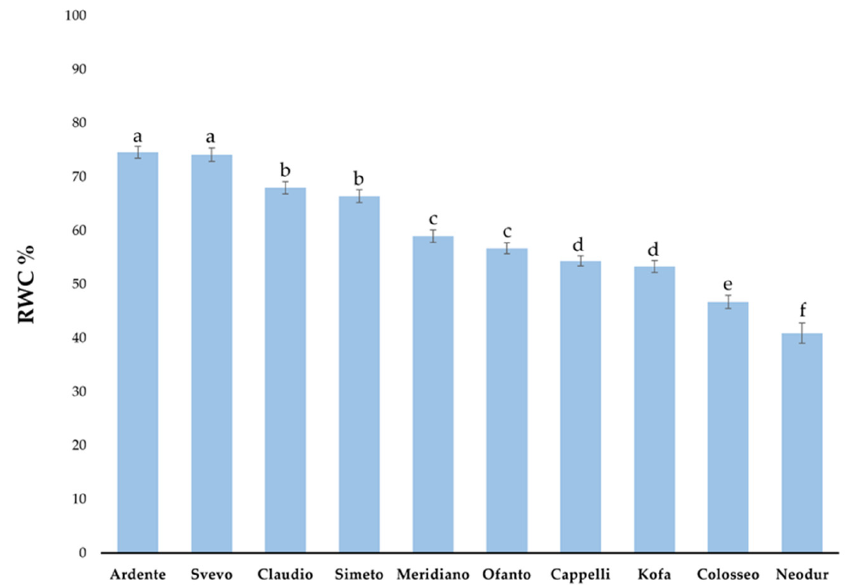
Figure 3. Relative water content (RWC) measured in seedlings of ten T. durum cvs in response to dehydration for 2 h. Different letters indicate a significant difference at p < 0.05 (Anova, Bonferroni- Holm’s post-hoc